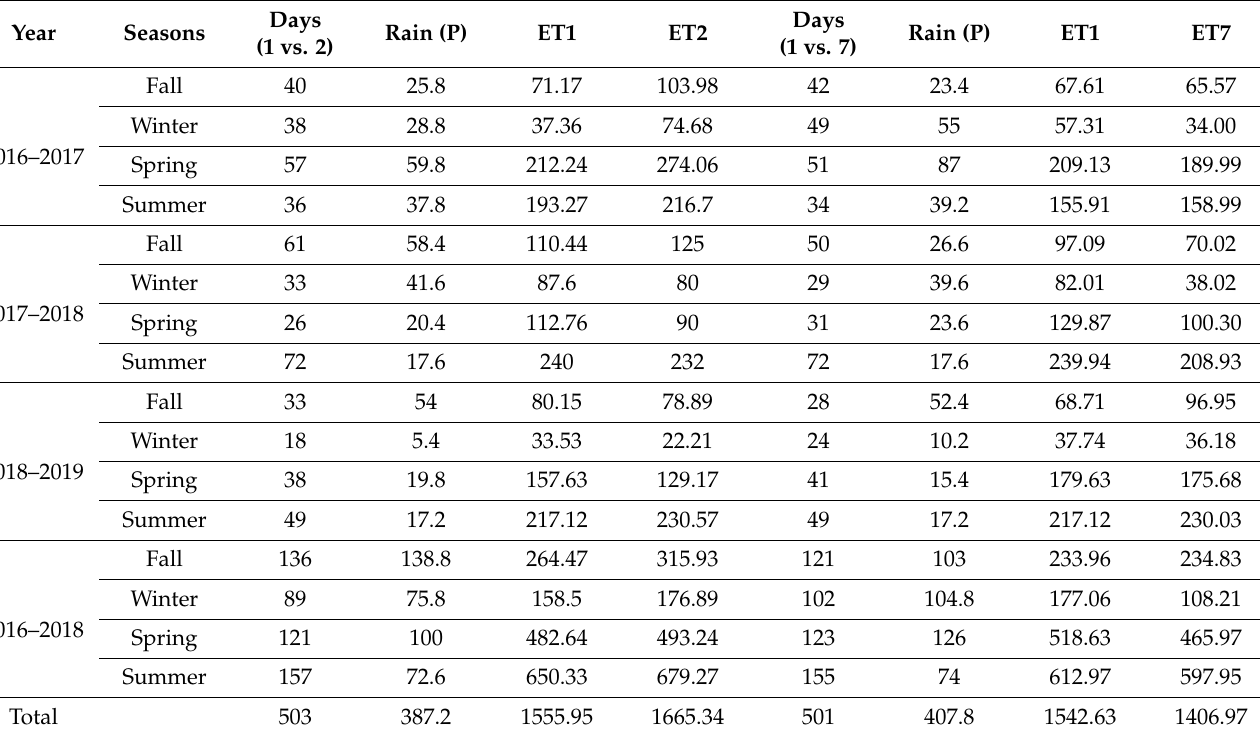
Table A5. Cumulative ET and P in mm for the lysimeters in common validated days for reference (herbaceous) and shrubs configurations. The couples’ lysimeter 1 vs. lysimeter 2 and lysimeter 1 vs. lysimeter 7 are